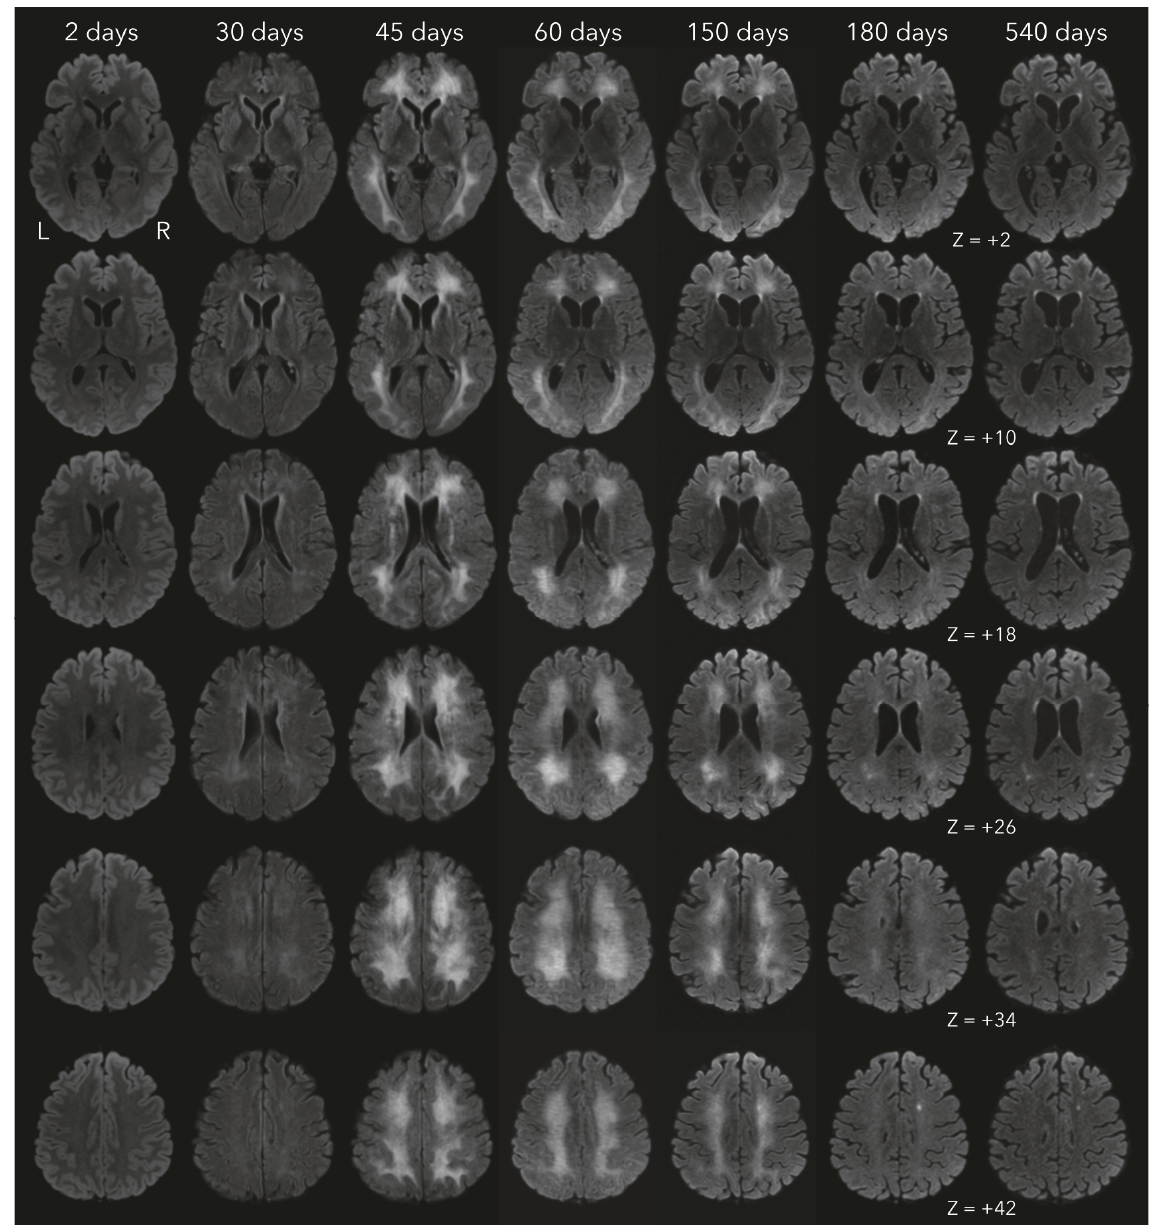
Figure 2: Comparison of MRI scans across different time-points after exposition. 30 and 45 days after initial event, FLAIR sequences show a diffuse and confluent hyperintensity involving predominantly the periventricular and deep white matter. Follow-up MRI scans (60, 150, 180, and 540 days after initial event) show gradual regression of the FLAIR